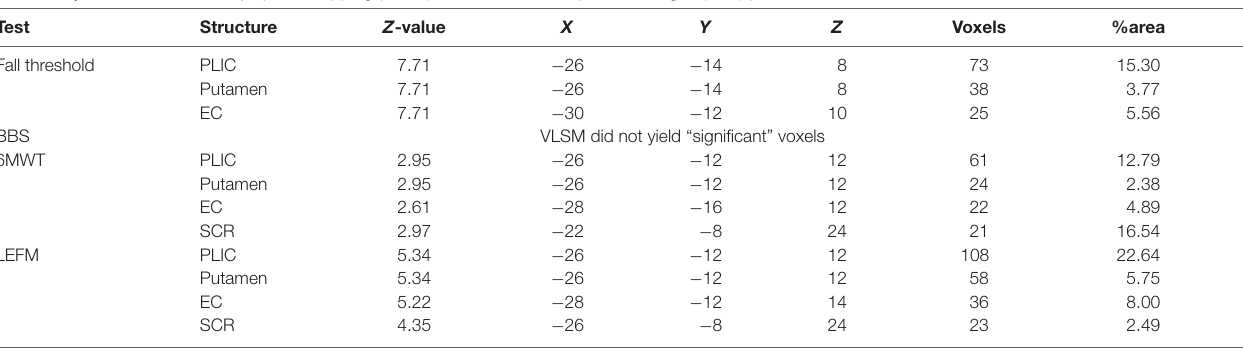
TABLE 4 | Voxel-based lesion symptom mapping (VLSM) results in left hemisphere damaged (LHD) patients, n = 22.